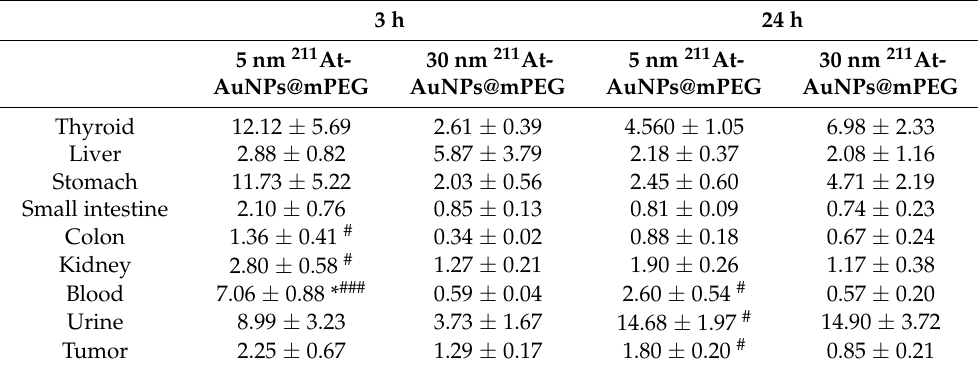
Table 1. Comparison of percentage distribution of injected dose per gram (% ID/g) of 5 nm and 30 nm 211